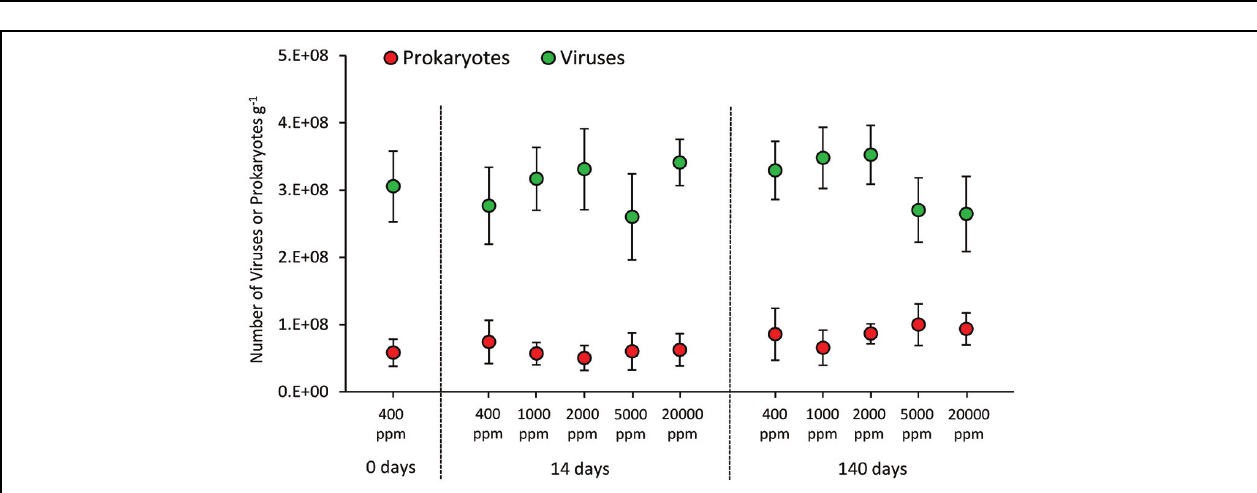
FIGURE 2 | (A) Extracellular aminopeptidase activities, and (B) cell-specific aminopeptidase activities and sedimentary protein turnover time in the different high-CO 2 experimental systems (1,000–20,000 ppm) and in the controls (i.e., 400 ppm), showing mean values and relative SDs. Significant differences between treatments and controls are indicated with asterisks: ∗ p < 0.05, ∗∗ p < 0.01, and ∗∗∗ p < 0.001.